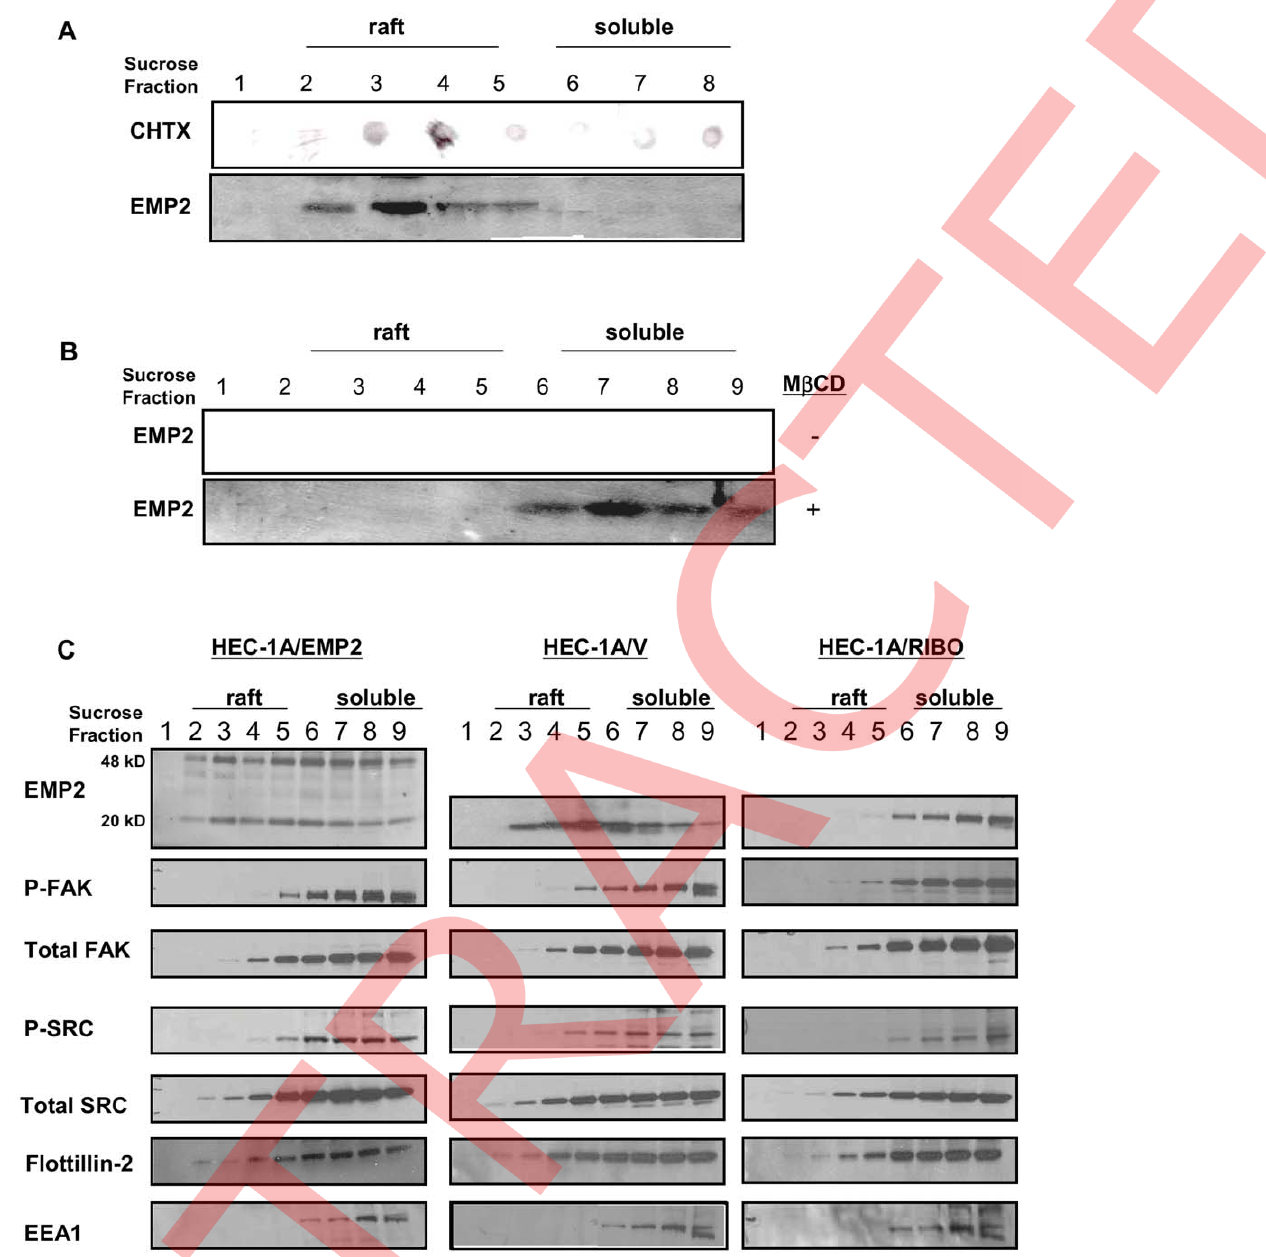
Figure 6. EMP2 forms a complex with FAK and Src in DIG lipid raft membrane domains. (A) EMP2 expression in HEC-1A lipid raft membrane domains was verified by Brij-58 insolubility. Cells were lysed in 1% Brij-58 and centrifuged in a sucrose density gradient. Nine fractions (500 m l each) were collected from the top of the gradient and tested for GM1 by a cholera toxin-HRP dot blot and for EMP2 ( , M r 20 kDa) by using SDS-PAGE and Western blot analysis. (B) To verify the cholesterol dependence of EMP2 expression within the lipid raft. HEC-1A cells were preincubated in the presence ( + ) or absence (–) of M b CB. Cells were lysed in 1% Triton X-100, gradient fractionated, and EMP2 expression detected by Western blot analysis. (C) HEC-1A/EMP2, HEC-1A/V, and HEC-1A/RIBO cells were lysed in 1% Triton X-100 and centrifuged as above. Samples were probed by Western blot analysis for EMP2, activated FAK, activated Src, total FAK, total Src, Flotillin-2, and EEA1. Experiments were performed independently three times with similar